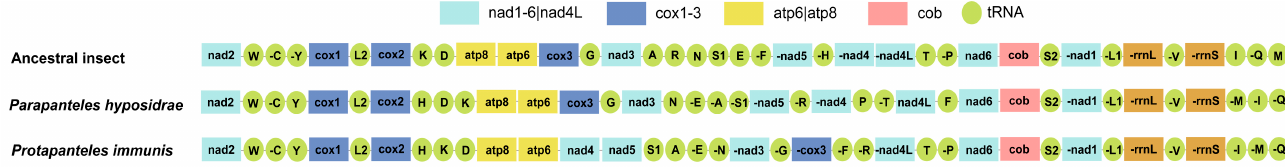
Figure 3. Gene rearrangement in the mitochondrial genome of Pa. hypsidrae and Pr. immunis . Frequent gene rearrangements have been reported in Braconidae in previous